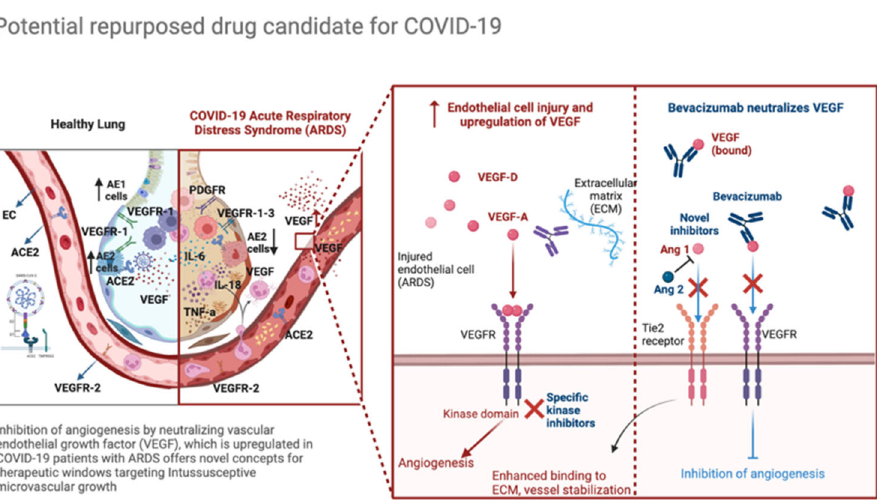
Figure 1. Potential repurposed drug candidate for COVID-19. Modulation of VEGF and angiogenesis hold the potential to slope the equilibrium between vascular homeostasis and viral-related damage. Bevacizumab has been used in ongoing clinical trials in critically ill patients with severe COVID-19 [107,119]. Knowledge of the molecular events governing tumour angiogenesis and intussusceptive microvascular growth has promoted several therapeutic strategies to block dysfunctional endothelial cells in COVID-19. Successful therapeutic targeting of VEGF and its receptors is the most promising strategy for the future. Endothelial cells are characterized by context-dependent and dynamic cell motility and interactions with soluble factors. Peptides derived from normal proteins by proteolytic cleavage, including endostatin and tumstatin, inhibit angiogenesis through mechanisms that include interfere with integrin function. Aberrant cell signaling-directed approaches and the inhibition of epidermal growth factor (EGF)-family receptors, whose signaling activity is upregulated in damaged endothelial cells, result in downregulation of VEGF and IL-8, while increasing the expression of the antiangiogenic protein thrombospondin-1. Ras/MAPK, PI3K/Akt, and Src kinase signaling shape cell proliferation and EC homeostasis, offering a crucial field of investigation [14,107,119] of alveolar type 1 (AE1) and type 2 (AE2) cells. Figure created with BioRender.com (accessed on 9 June